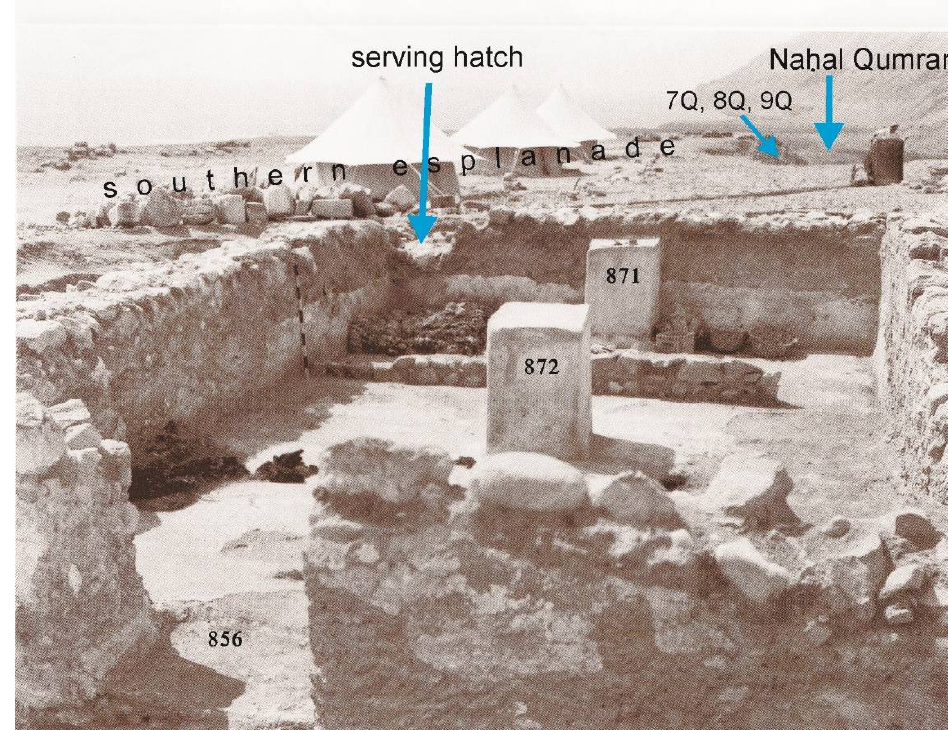
Figure 4. Room 86. Based on Humbert and Chambon 2016.